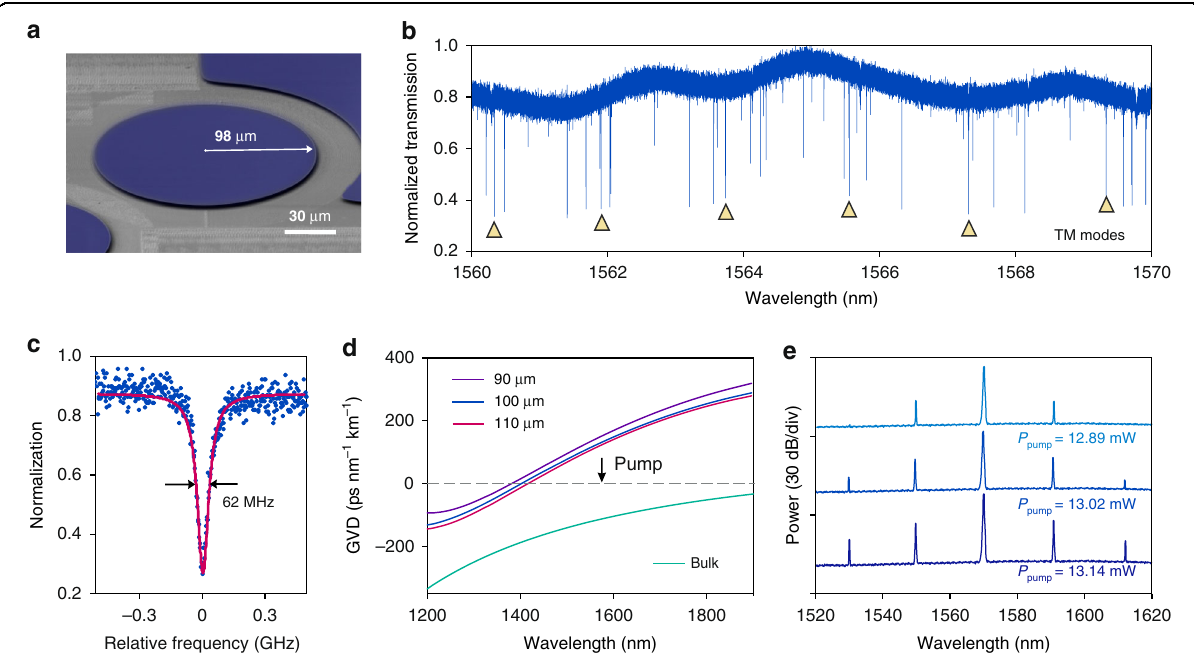
–0.3 Fig. 1 Characterization of 4H-SiC integrated photonic microresonators. a False-colored scanning electron microscopy (SEM) image of a 4H-SiC microdisk resonator with a radius of 98 µm. The SiC is blue-colored. b Normalized power transmission spectrum of an over-coupled microresonator with the transverse-magnetic (TM) polarization. The fundamental TM mode family is identi fi ed and marked by triangular symbols. Other resonances belong to higher-order TM modes of the microresonator. c A resonance of the fundamental TM mode with a loaded linewidth of 62 MHz extracted from the Lorentzian fi t (red line), corresponding to a loaded Q factor of 3.1 × 10 6 . d Numerical simulations of group-velocity dispersions (GVD) of 800 nm thick SiC microdisks with different radii. e Optical spectrum of the initially parametric oscillation with different input